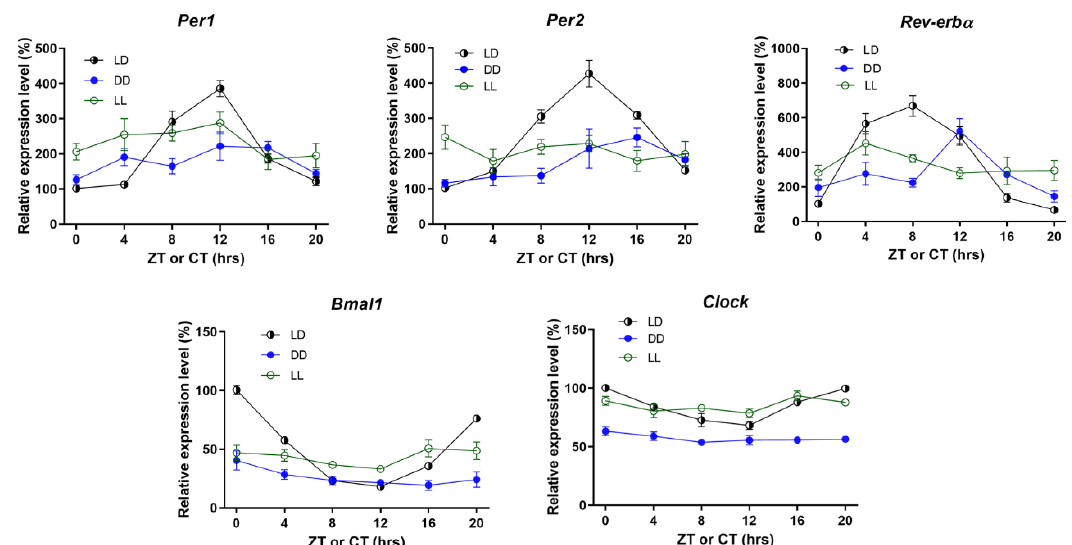
Figure 1. Relative transcript profiles of circadian clock genes in the cochlea at 6 zeitgeber times (ZTs) in the LD (light–dark), and at 6 circadian times (CTs) in constant dark (DD) and constant light (LL) groups. Each value represents the percentage change relative to ZT0 of the LD group, which was normalized to 100%. Data are mean ± SEM. n = 8–10 for each time point in each condition. Table 1. p -value of F test to detect the circadian rhythmicity of mRNA transcripts of circadian clock genes in the cochlea by CircWave software. LD